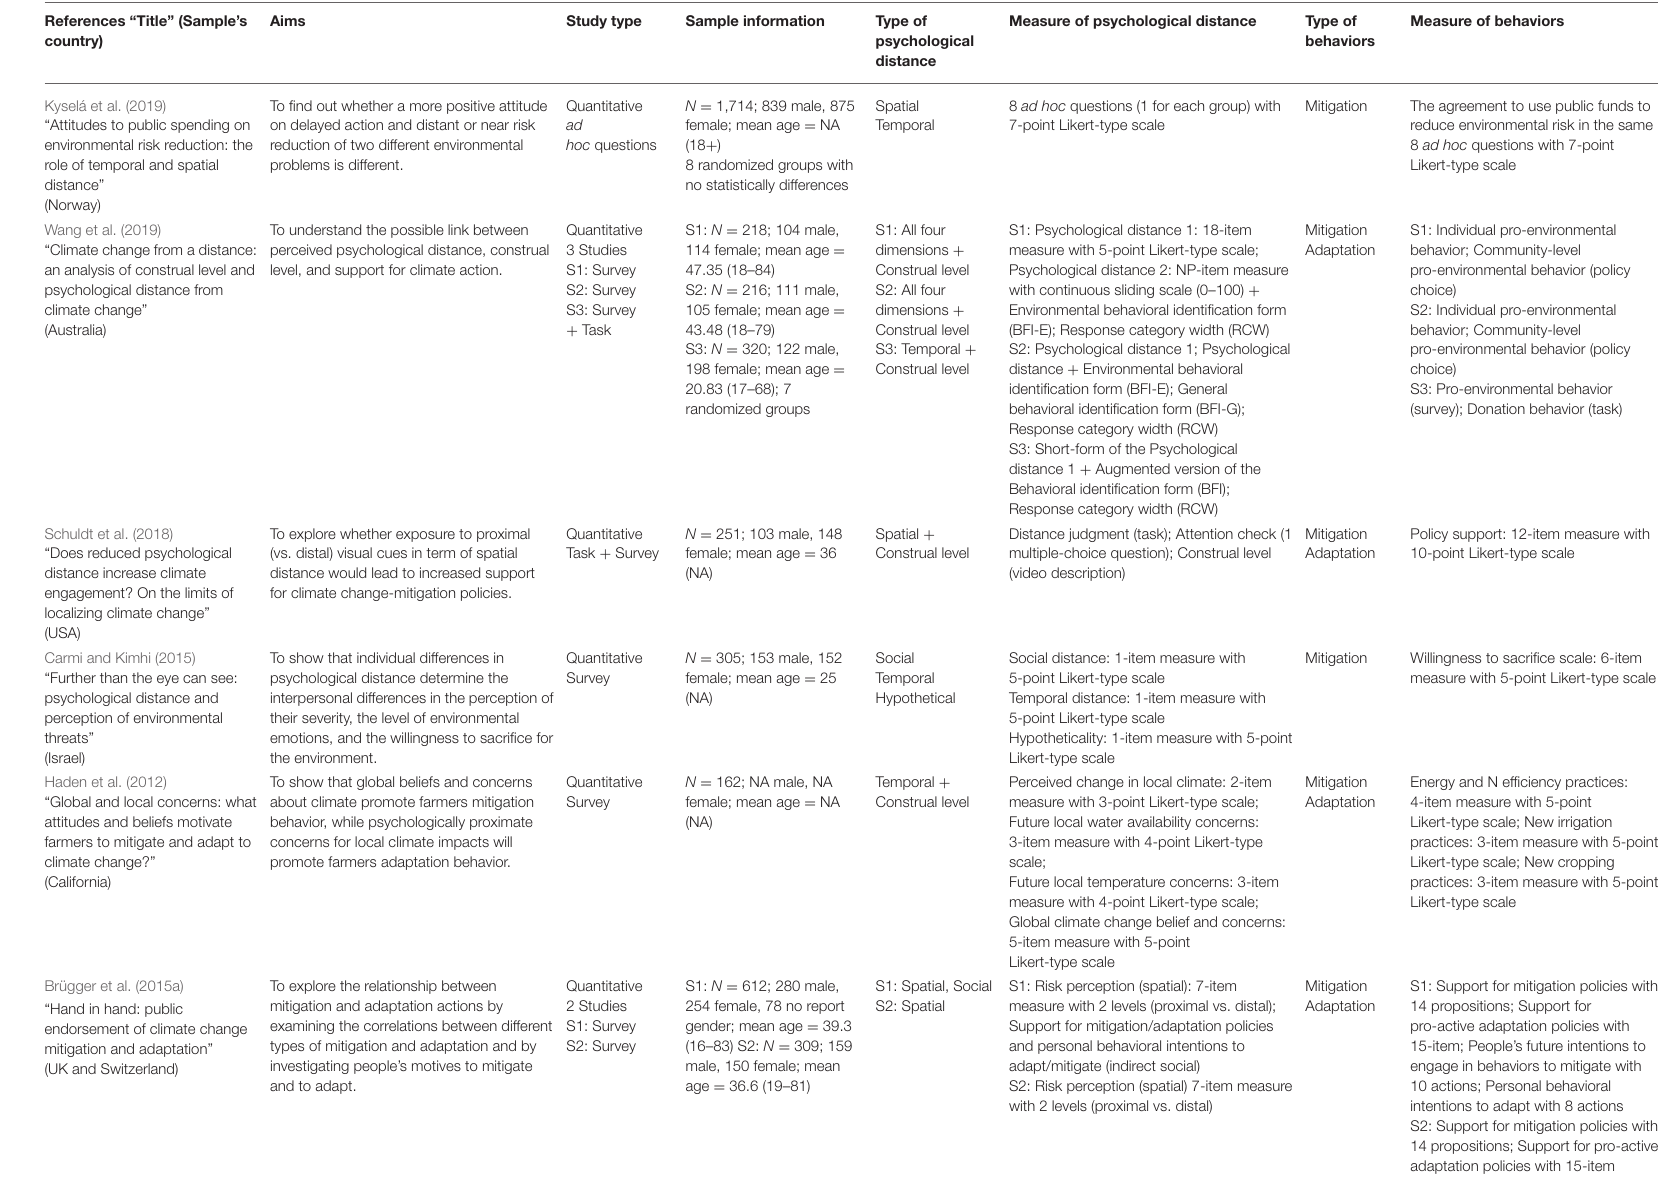
TABLE 1 | Features of included studies assessing psychological distance and climate change